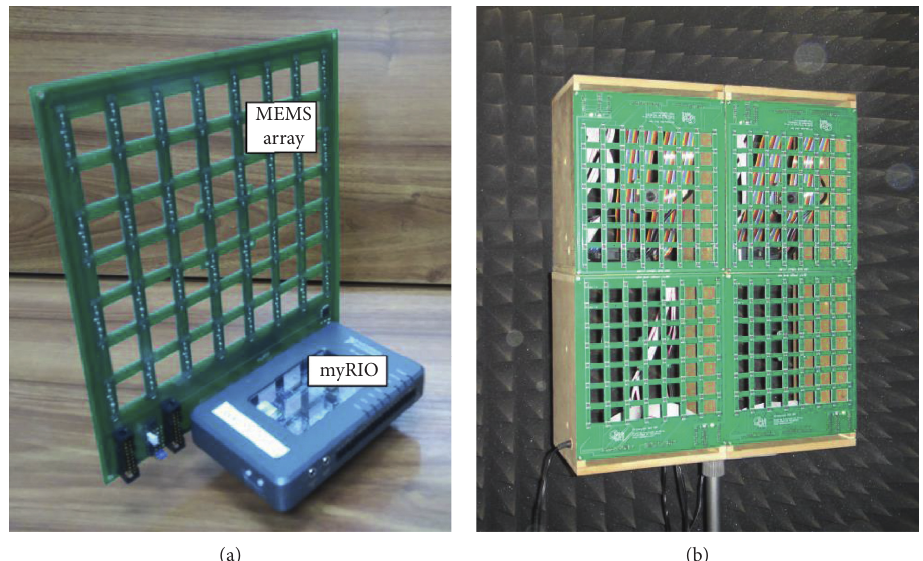
Figure 1: (a) Array module with myRIO and MEMS array board. (b) Complete acoustic acquisition system.